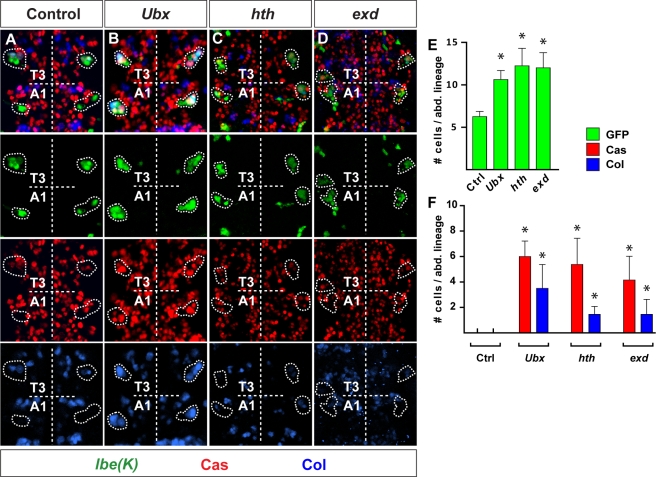
Suppression of thoracic-like NB 5–6 lineage progression by Ubx and Pbx/Meis.(A) At stage 15, lbe(K)-Gal4 reveals a larger NB 5–6 lineage in thoracic segments, when compared to abdominal ones. Expression of Cas and Col is only evident in the NB 5-6T lineage. (B–D) At stage 15, in Ubx, hth, and exd mutants, NB 5-6A lineage is larger and expression of Cas and Col is evident. (E and F) Quantification of GFP, Cas, and Col positive cells/NB 5-6A lineage, in control, Ubx, hth, and exd mutants, at stage 14 (n>8 lineages). Asterisks denote significant difference compared to thoracic control (p<0.01, Student two-tailed test). Genotypes: (A) lbe(K)-Gal4, UAS-nmEGFP/+; lbe(K)-Gal4, UAS-nmEGFP/+. (B) lbe(K)-Gal4,UAS-nmEGFP;Ubx. (C) lbe(K)-Gal4,UAS-nmEGFP;hth5E04/hthDf3R. (D) exdB108, FRT18D/y; lbe(K)-Gal4, UAS-nmEGFP/+; lbe(K)-Gal4, UAS-nmEGFP/+.